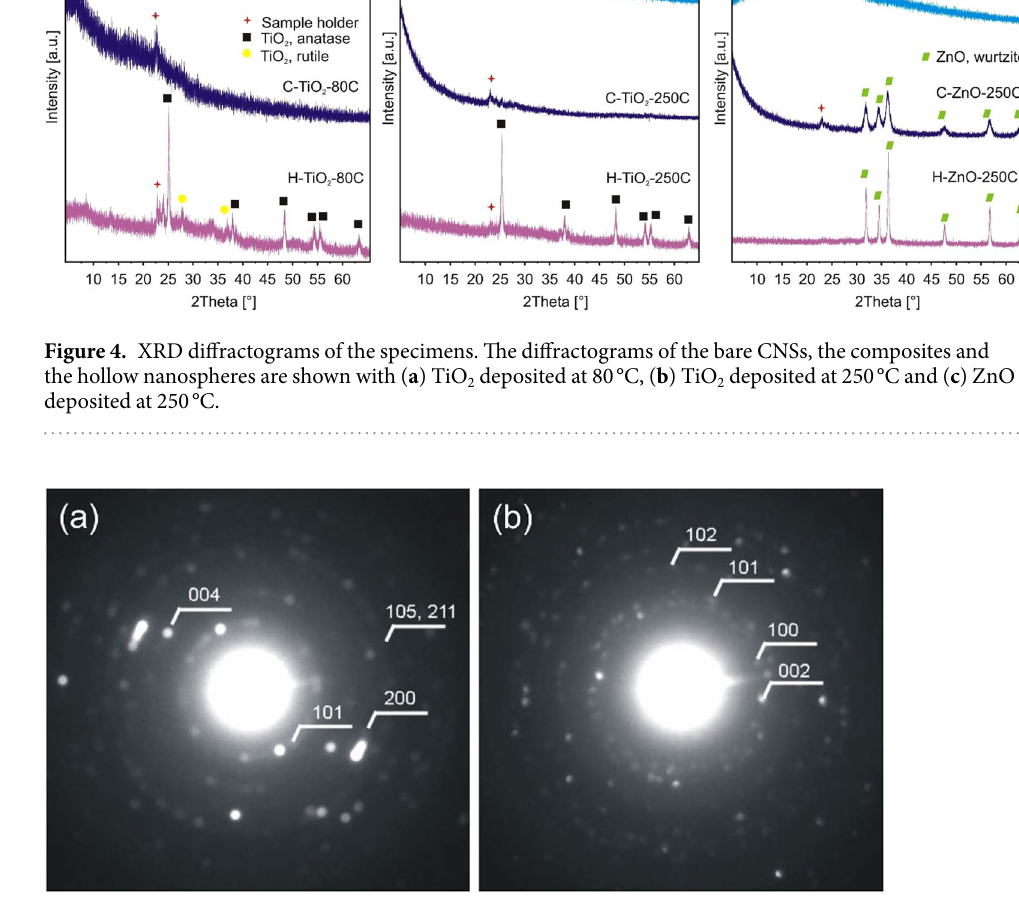
Figure 5. Electron diffraction of the hollow spheres. ( a ) H-TiO 2 -250C and ( b ) H-ZnO-250C. The numbers are corresponding to the Miller indices of the TiO 2 and ZnO, respectively.